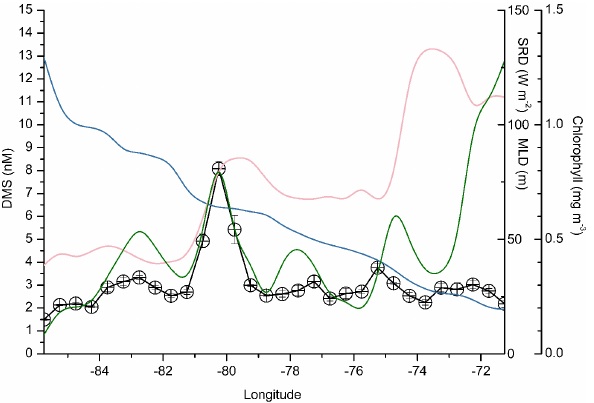
Fig. 4. A west-east section summarising the changes in seawater DMS (black), mixed layer depth (MLD) (blue), solar radiative dose (SRD) (pink) and chlorophyll (green) during the VOCALS REx cruise. The latitudinal range is ∼ 11.5–20.5 ◦ S although 95% of the data is between 17.0 ◦ S and 20.5 ◦ S. Data are averaged over 0.5 ◦ longitudinal bins. The error bars on the DMS points represent ± 1 standard error. All data were in situ or derived from in situ data. MLD is defined as a change of 0.1 ◦ C from 10m depth. SRD and MLD share the same axis to aid